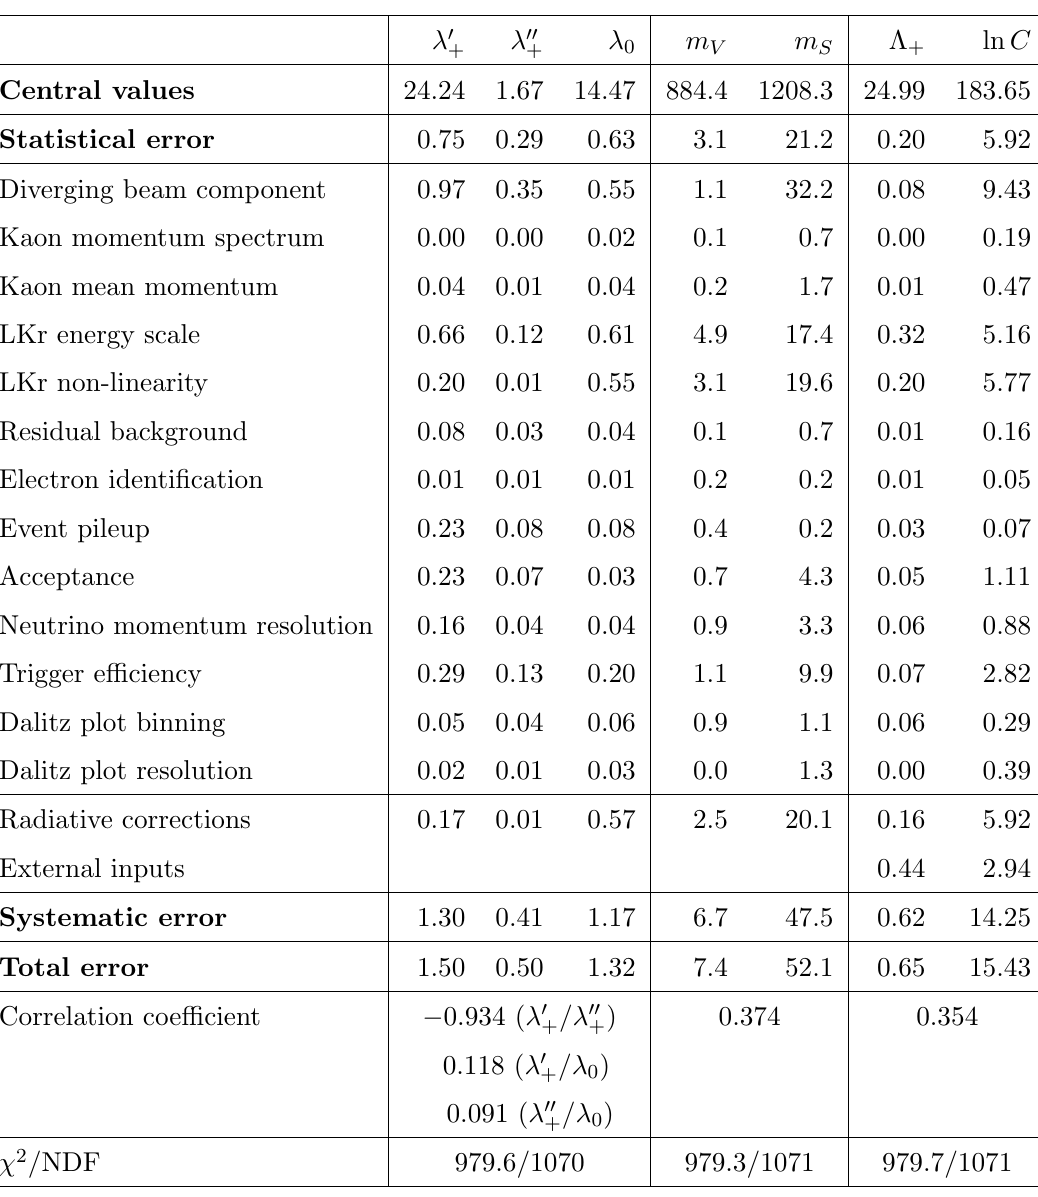
Table 5 . Form factor results of the joint K (cid:6) and systematic uncertainties. The units of (cid:21) 0 The units of m V and m S values and errors are MeV = c 2